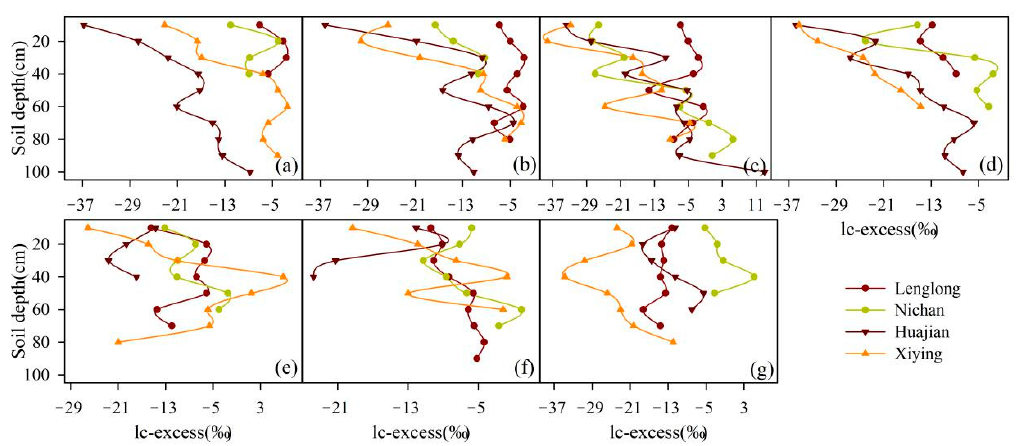
Figure 6. Profile variation of soil water lc-excess at the four stations in the study area (( a ) Apr; ( b ) May; ( c ) Jun; ( d ) July; ( e ) Aug; ( f ) Sept; ( g ) Oct).